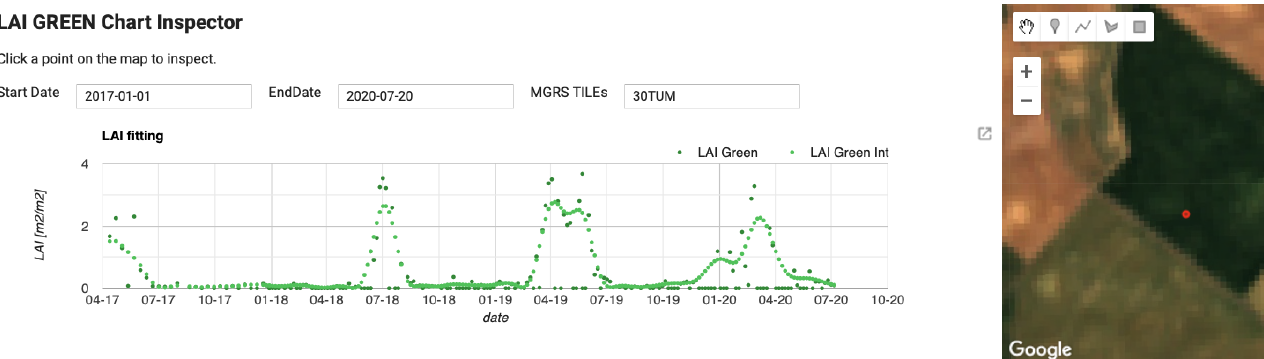
Figure 6. S2 acquisition over tile 30TUM on 27 May 2019: RGB ( a ), LAI G map ( b ) and gapfilled LAI G map ( c ) from GPR model applied in GEE to ± 35 dd span S2 collection. In ( d – f ), the same quantity zoomed onto the bottom-right corner.